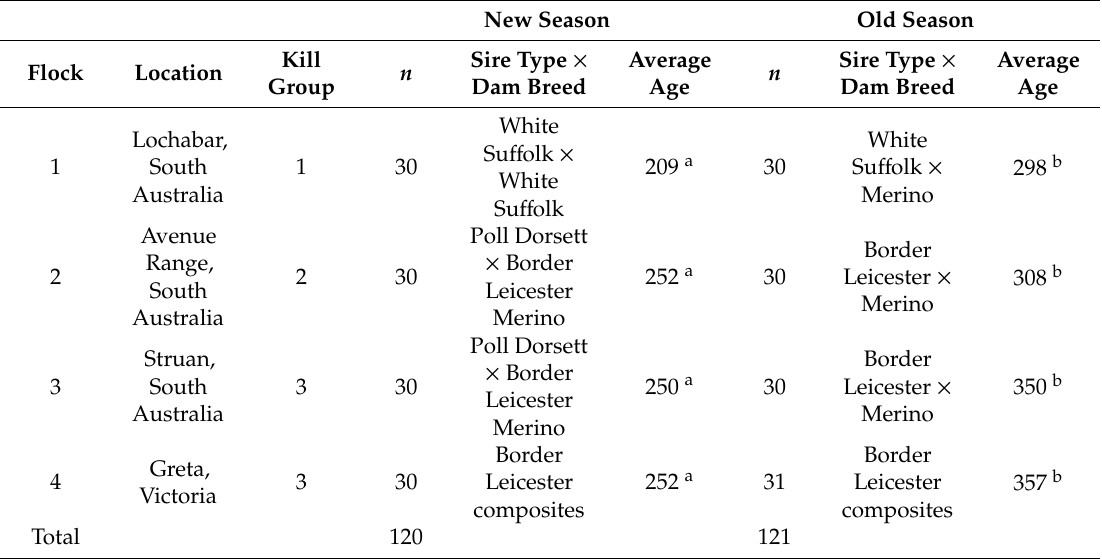
Table 1. Location, number, breed, average age and kill group of new season and old season lambs within each